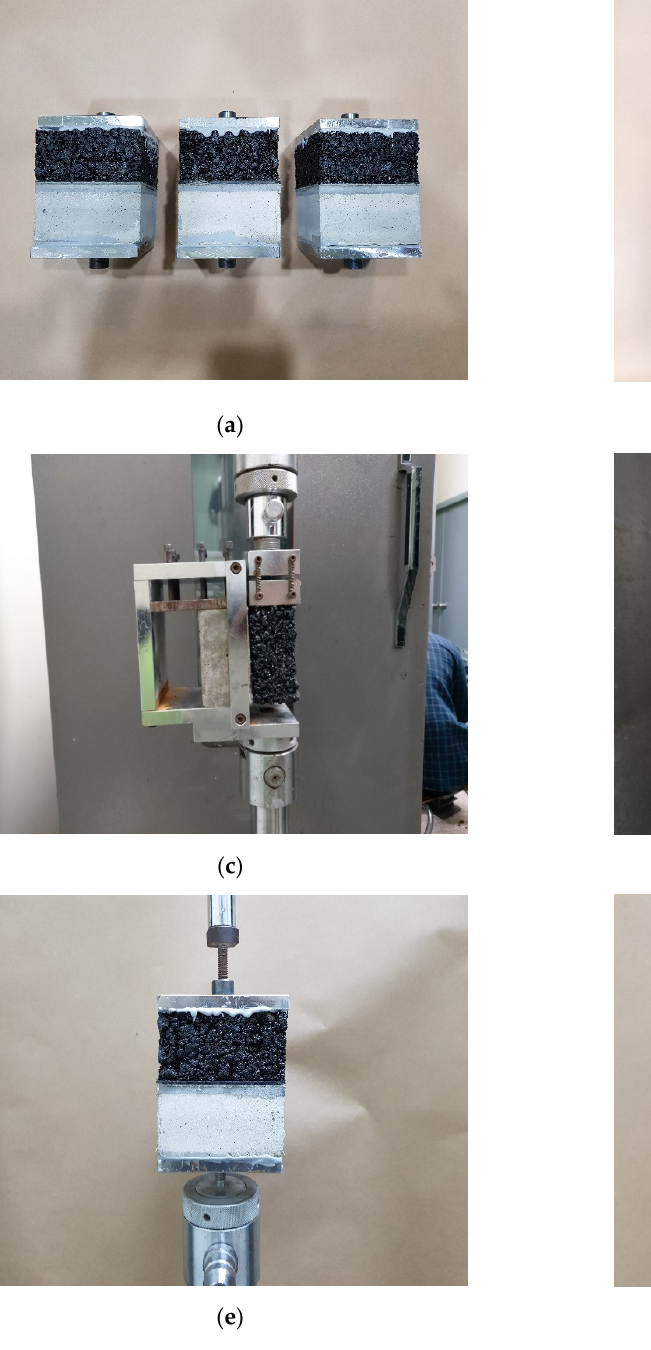
Figure 6. Evaluation of methods of APC pavement specimens with applied waterproofing sheet; ( a ) APC specimens, ( b ) water immersion test, ( c ) shear adhesive and deformation test, ( d ) shear and deformation test result, ( e ) tensile test, ( f ) tensile adhesive strength test result.